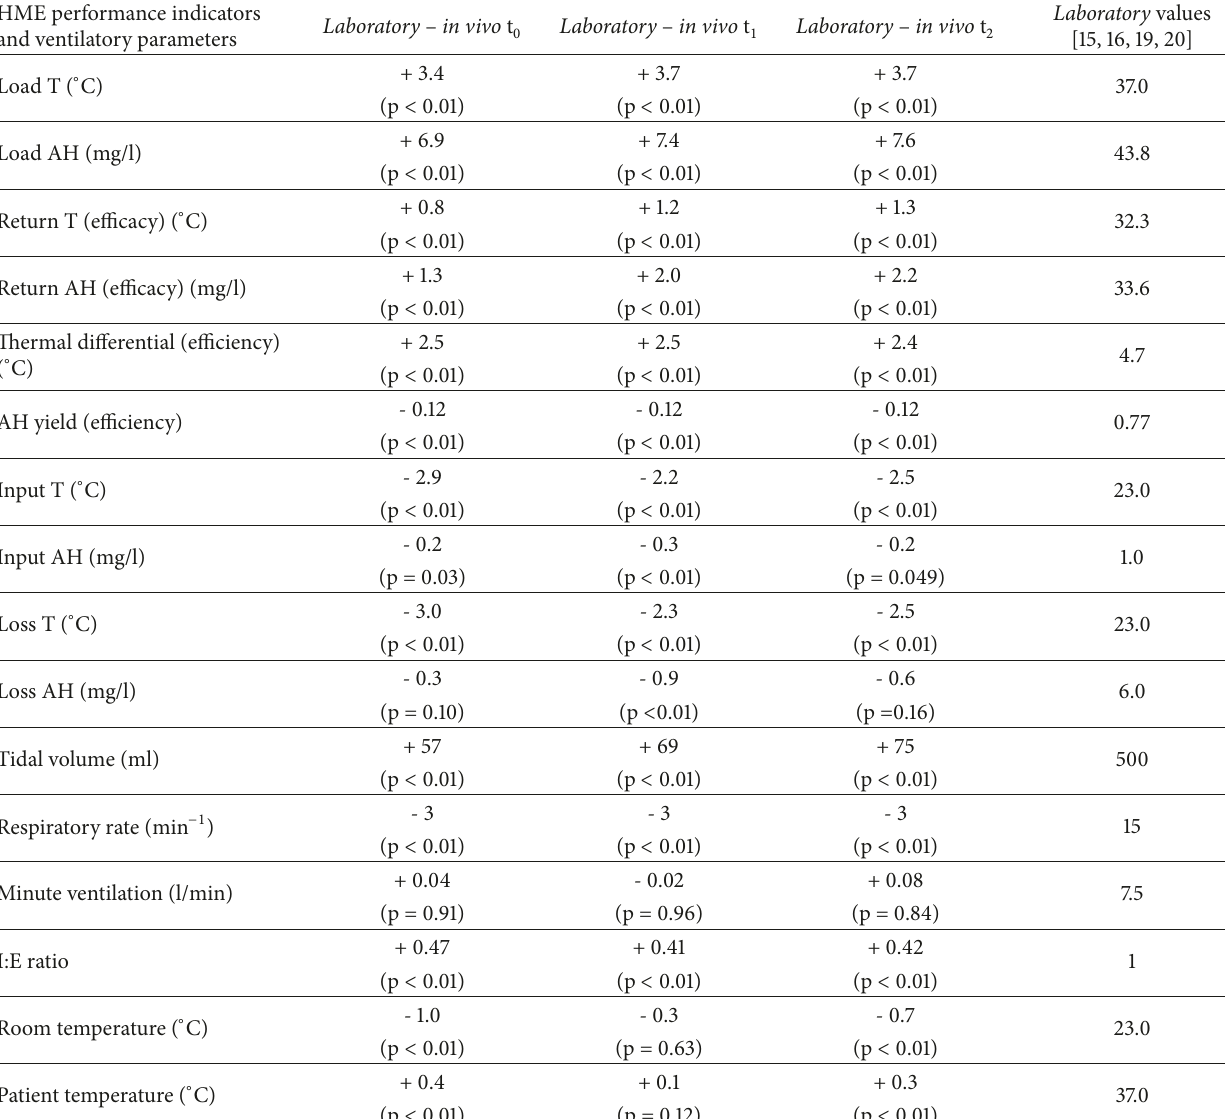
Table 3: Comparison of temperature (T) and absolute humidity (AH) of Heat and Moisture Exchanger (HME) performance indicators between laboratory values as declared by the manufacturer and in vivo measured values. All values are expressed as laboratory values minus in vivo values and were measured at a tidal volume of 500